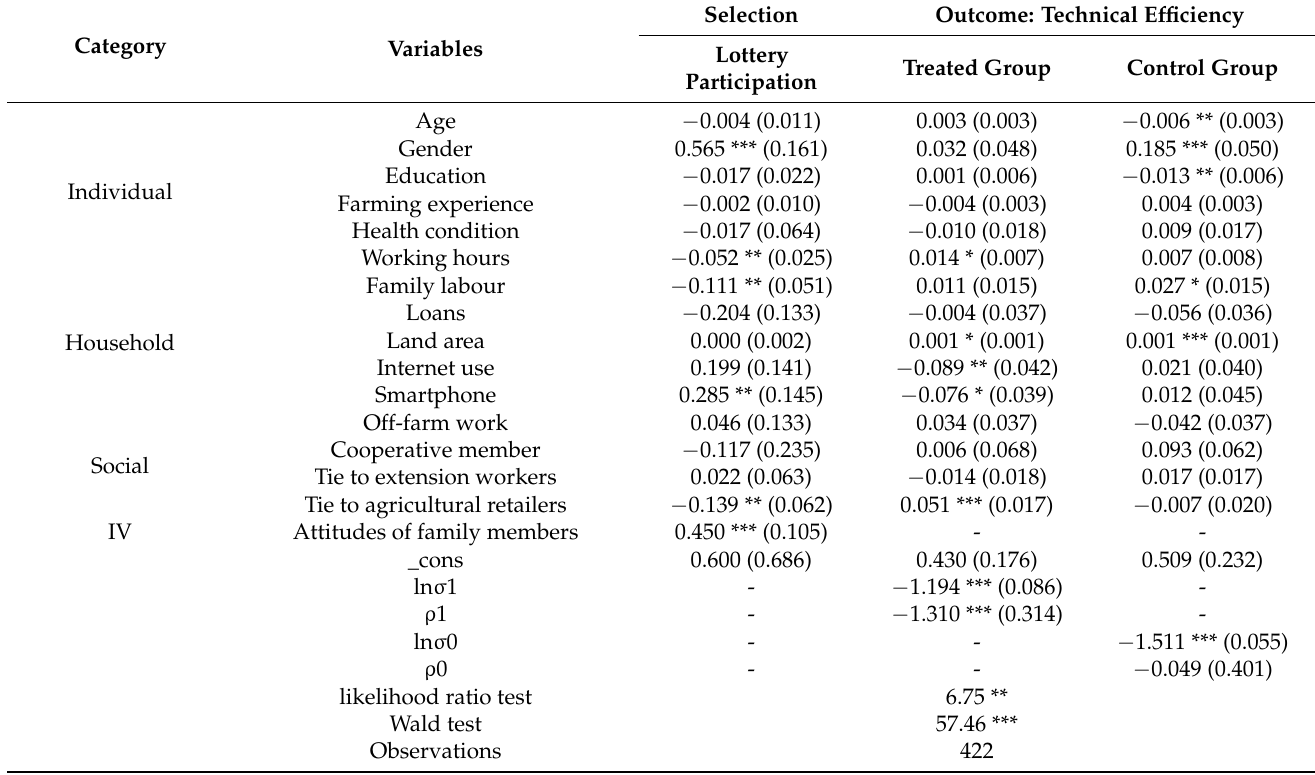
Table 5. The ESR estimation